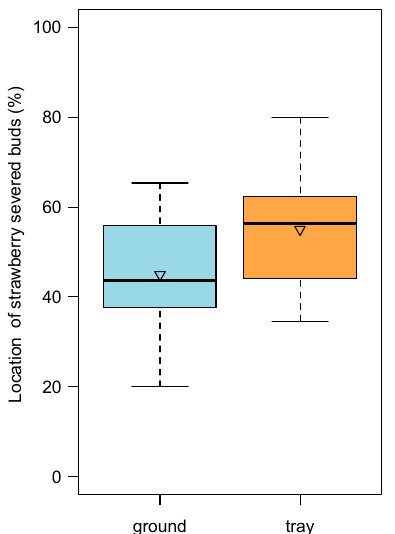
Figure 9. Location of strawberry severed buds between tray substrate surface and ground (intercepted by the hammock). The boxes enclose the first and third quartiles; the ends of the whiskers represent the 5th/95th percentiles, the solid lines the median and the triangle the mean.